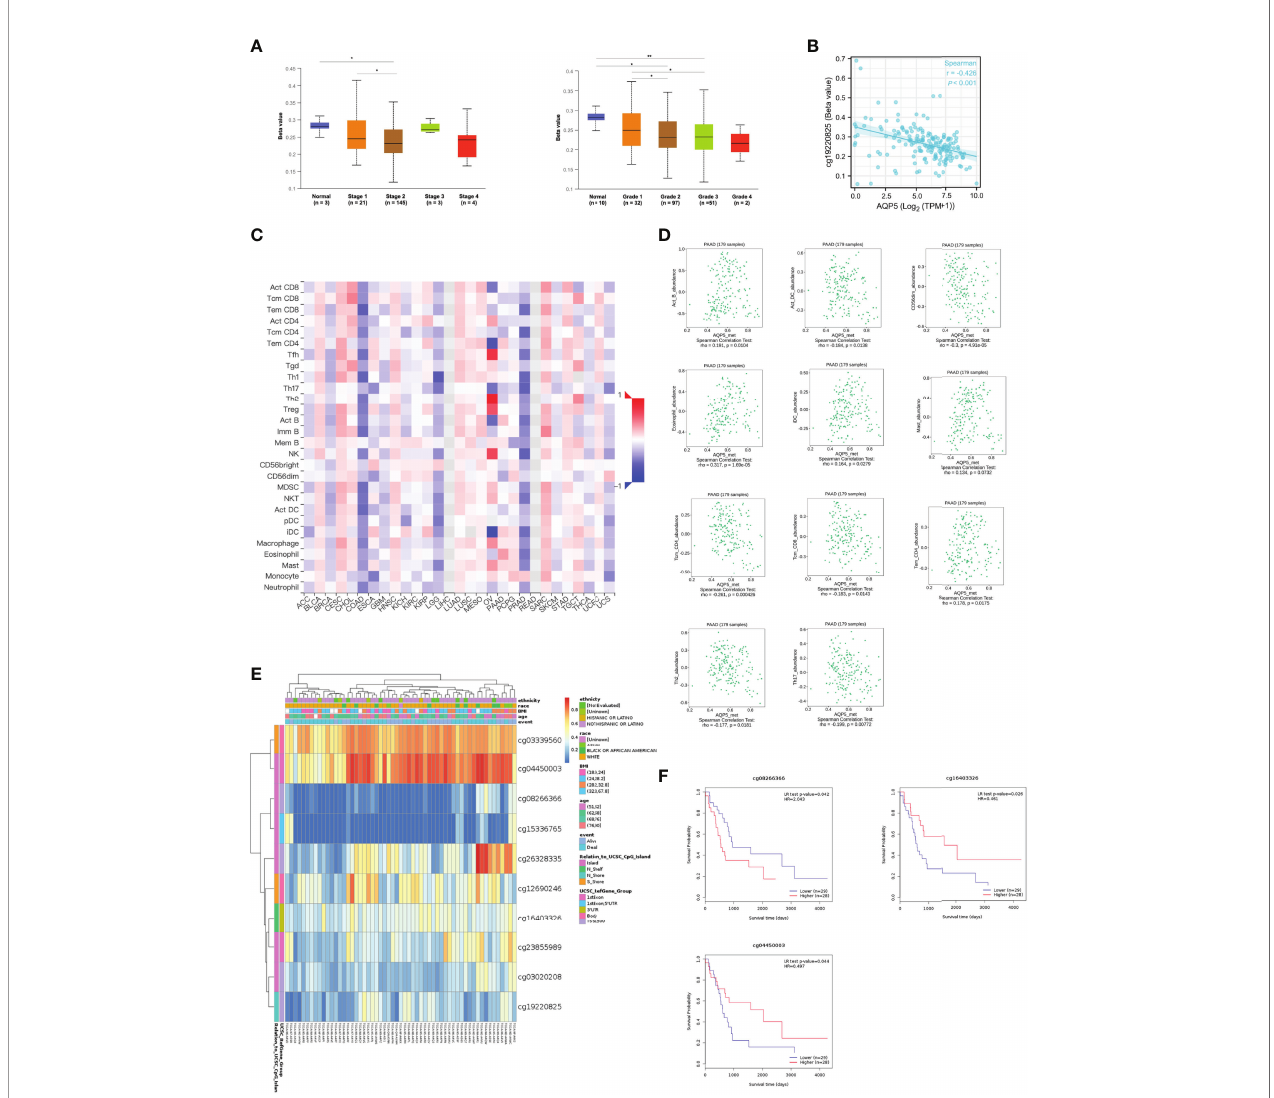
FIGURE 6 | DNA methylation levels of AQP5 and its prognostic value in PAAD. The difference of promoter methylation level of AQP5 between tumor stage (A) and grade (B) in PAAD. (C) The expression of AQP5 correlated with AQP5 promoter methylation. (D) The heatmap of DNA methylation at CpG sites of AQP5 in PAAD. (E) The survival analysis of AQP5 promoter methylation in patients with PAAD. (F) Relationship between AQP5 promoter methylation and 28 subtypes of tumor- in fi ltrating immune cells in different kinds of tumors. (G) Association between the methylation status of AQP5 with immune in fi ltrates in PAAD. *p < 0.05, **p < 0.01.